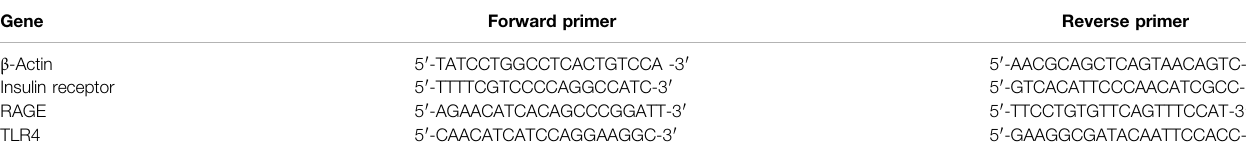
TABLE 1 | The primers